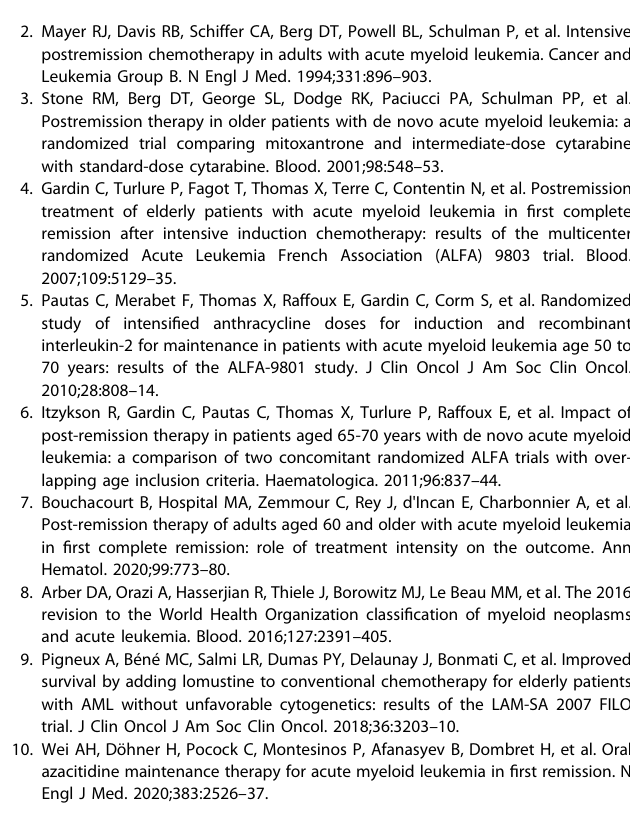
Fig. 1 Outcomes among 395 patients over 60 with acute myeloid leukemia who achieved complete remission/complete remission with incomplete hematological recovery after an intensive fi rst induction course. A Overall survival by treatment arm; B Relapse-free survival by treatment arm; C Cumulative incidence of relapse by treatment arm; D Cumulative incidence of nonrelapse mortality by treatment arm. HR hazard ratio, CI con fi dence